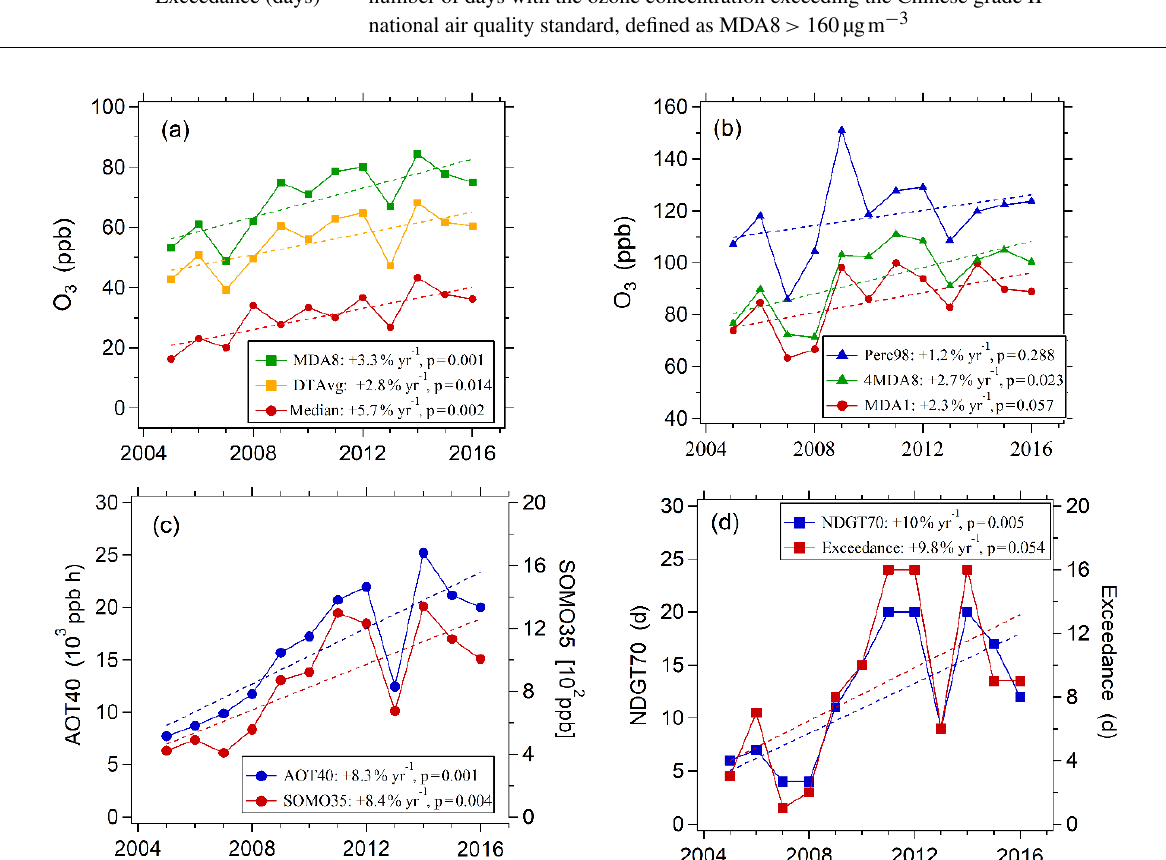
Figure 2. Variations in multiple O 3 metrics at the PKUERS site in Beijing in August between 2005 and 2016.